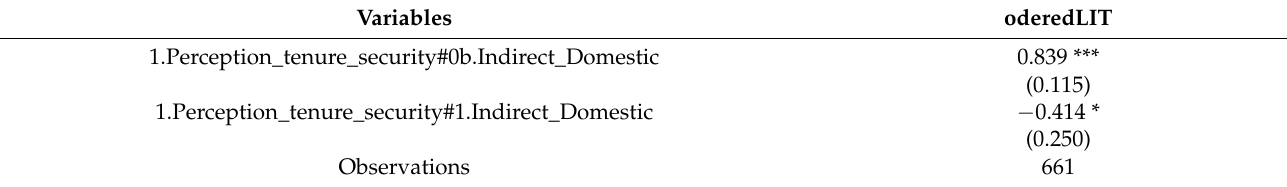
Table 11. Effect of indirect exposure to LSLA by domestic entities through tenure